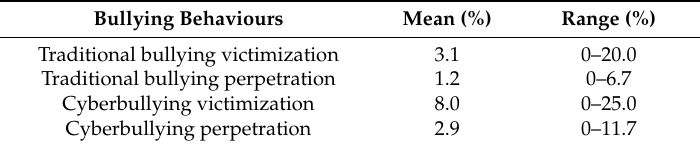
Table 2. Proportions of students reporting bullying behaviours across schools ( n =